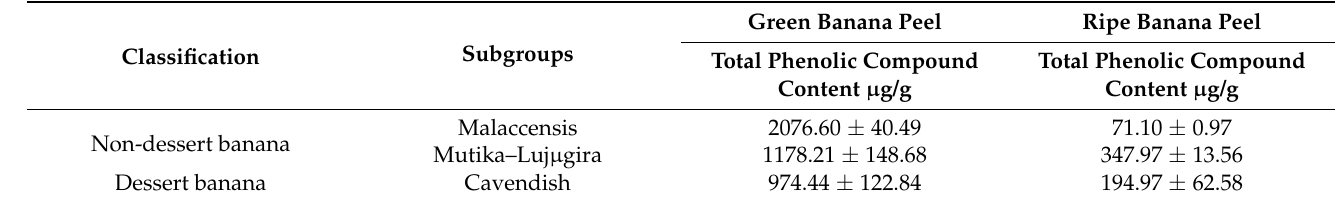
Figure 2. The accumulation histogram of total phenolic compound content in green fruit peel and ripe fruit peel of 10 banana cultivars. Note: Pah: Pahang, Ink: Inkira, Kaz: Kazirakwe, BX: Brazilian, RK2: Reke No. 2, RK4: Reke No. 4, NTH: Nantianhuang, BD: Baodaojiao, ZJ8: Zhongjiao No. 8, YJ1: Yunjiao No. 1; Mark “I” stands for Malaccensis subgroup; mark “II” stands for Mutika–Luj µ gira subgroup; mark “III” stands for Cavendish subgroup. Table 8. Comparison of the total phenolic compound content in three banana subgroups with different